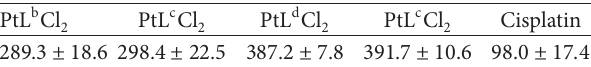
Table 2: 13 C NMR shifts difference ( Δ𝛿 , ppm) between L a–e ligands and PtL a–e Cl